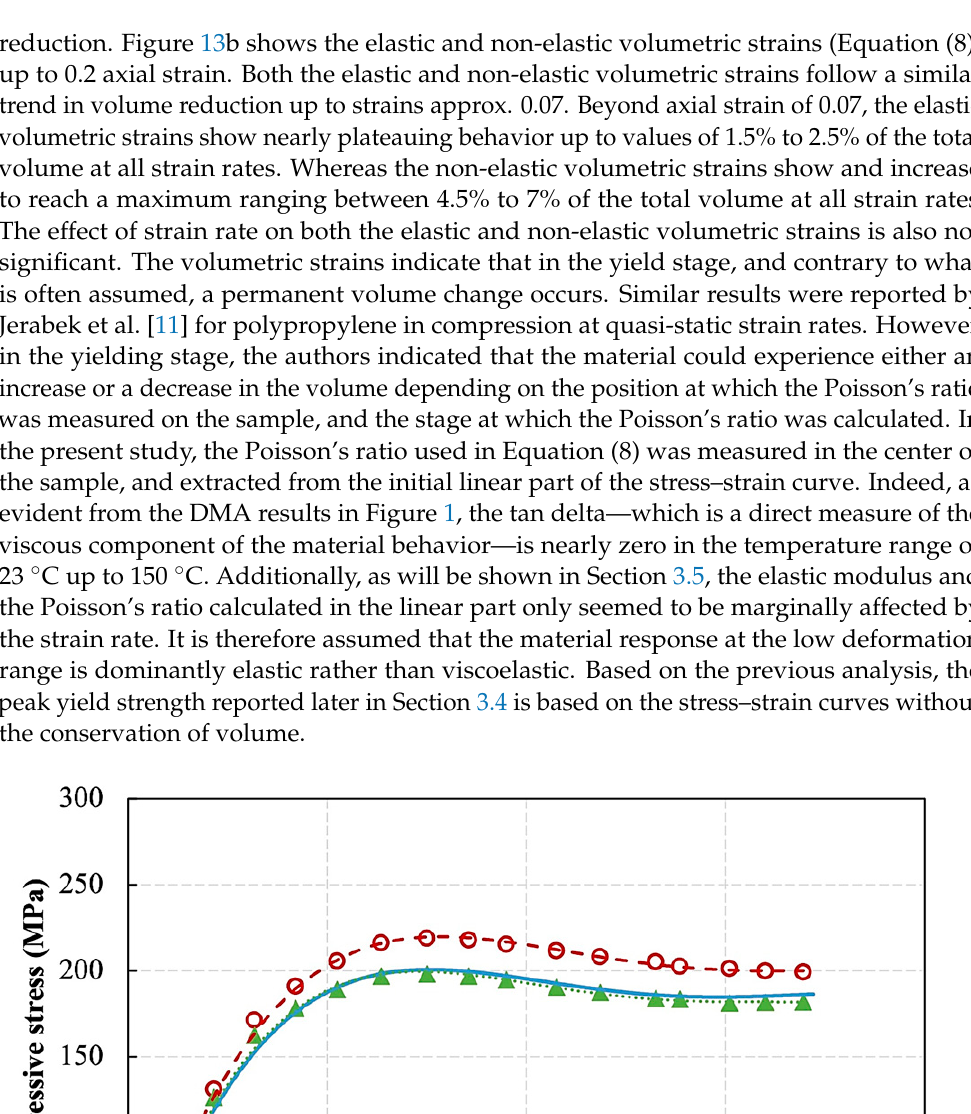
Figure 13. Variation of the relative volume change on the neat epoxy resin as a function of true axial strains at different strain rates during compression: ( a ) volumetric strain, ( b ) elastic and non-elastic volumetric strain. 3.4. Compressive Stress–Strain Response of RTM6 Epoxy at Different Strain Rates Figure 14 shows the true stress–true strain responses of RTM6 epoxy at different strain rates based on measurements from the LVDT and classical Hopkinson analysis. The purpose here is to show the complete response of the material also at higher levels of strains. The indicated strain rates correspond to the strain rate at the yielding stage (calculated in the second region, see Section 3.1). At least three experiments were performed for each testing condition. The curves shown are representative curves for each testing condition. It can be seen that the compressive behavior of the tested epoxy is strain rate sensitive. The true stress–true strain response for all materials follows four different regions: (1) an initial region corresponding to the material’s elastic and viscoelastic behaviors, (2) a non-linear region corresponding to the yielding of the material, which ( a )